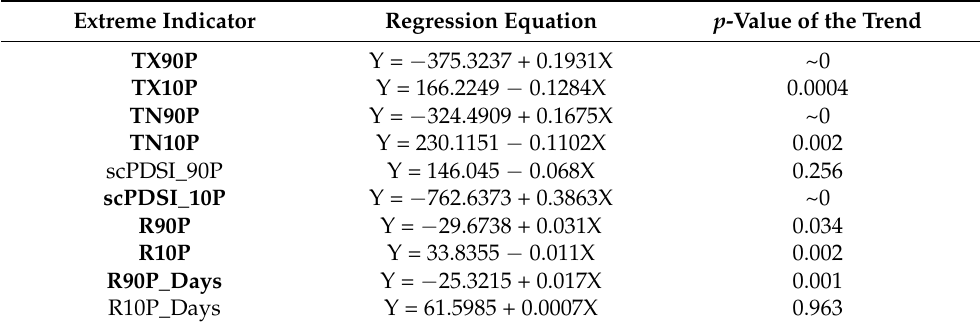
Table 2. The significance of the trends in the extreme indexes is tested by using the Student’s t -test, and the p -value of the trend is given after the regression equation. Boldface index name indicates a statistically significant trend at 95% confidence